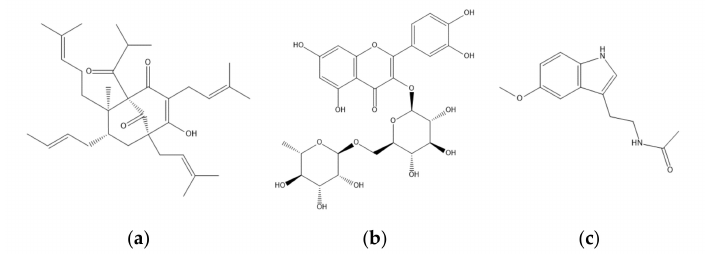
Figure 1. Chemical structures of the bioactive constituents of St. John’s wort: ( a ) hyperforin, ( b ) rutin, and ( c ) melatonin.